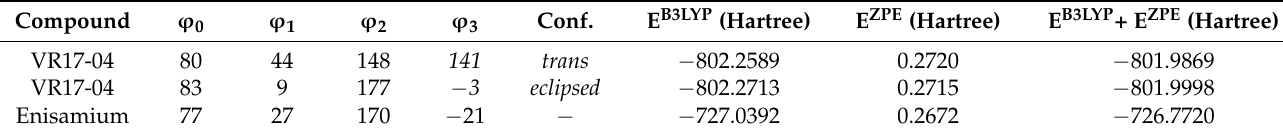
Table 1. Quantum chemical (DFT B3LYP/6-31G*) geometry optimization of VR17-04 and enisamium. The dihedral angles ( ϕ 0, ϕ 1 , ϕ 2 , ϕ 3 ) that define the conformation of VR17-04 and enisamium are reported. VR17-04 allows two conformations at ϕ 3 trans and eclipsed , respectively. The estimated energies (E B3LYP ) and zero-point energies (E ZPE ) are reported in Hartree. The ground state energy (E B3LYP + E ZPE ) are reported in Hartree. The energy difference between the two conformations ( trans , eclipsed ) in VR17-04 correspond to 0.0129 Hartree or 8.095 kcal mol − 1 ).